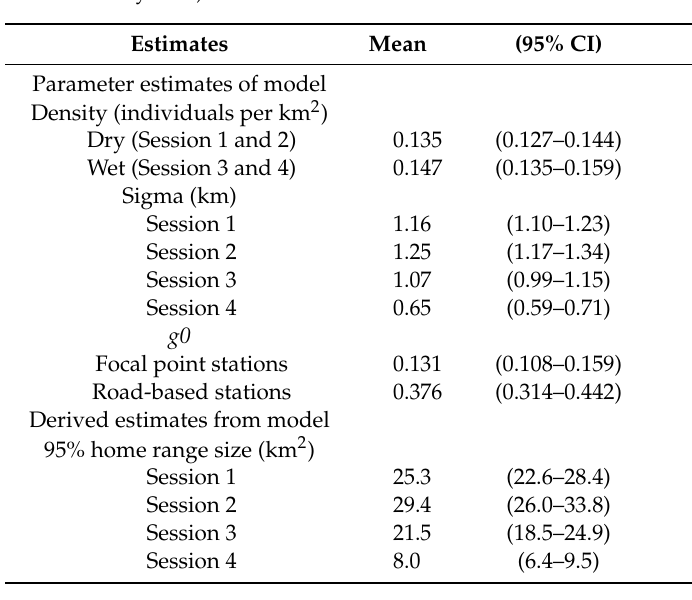
Table 1. Parameter estimates (density, sigma and g0 ) and derived estimates (95% bivariate home range size) from the final model of a spatially explicit multi-session mark–resight model, using a half-Normal detection function, for a dingo population in the NPA of Queensland, Australia, monitored from